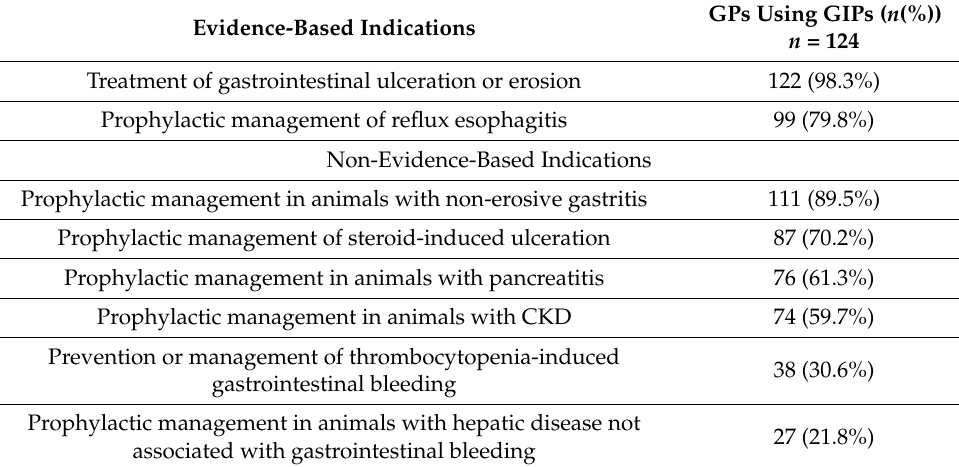
Table 2. Evidence- and non-evidence-based therapeutic indications for use of GIPs among Portuguese GPs, taking as a reference the ACVIM consensus